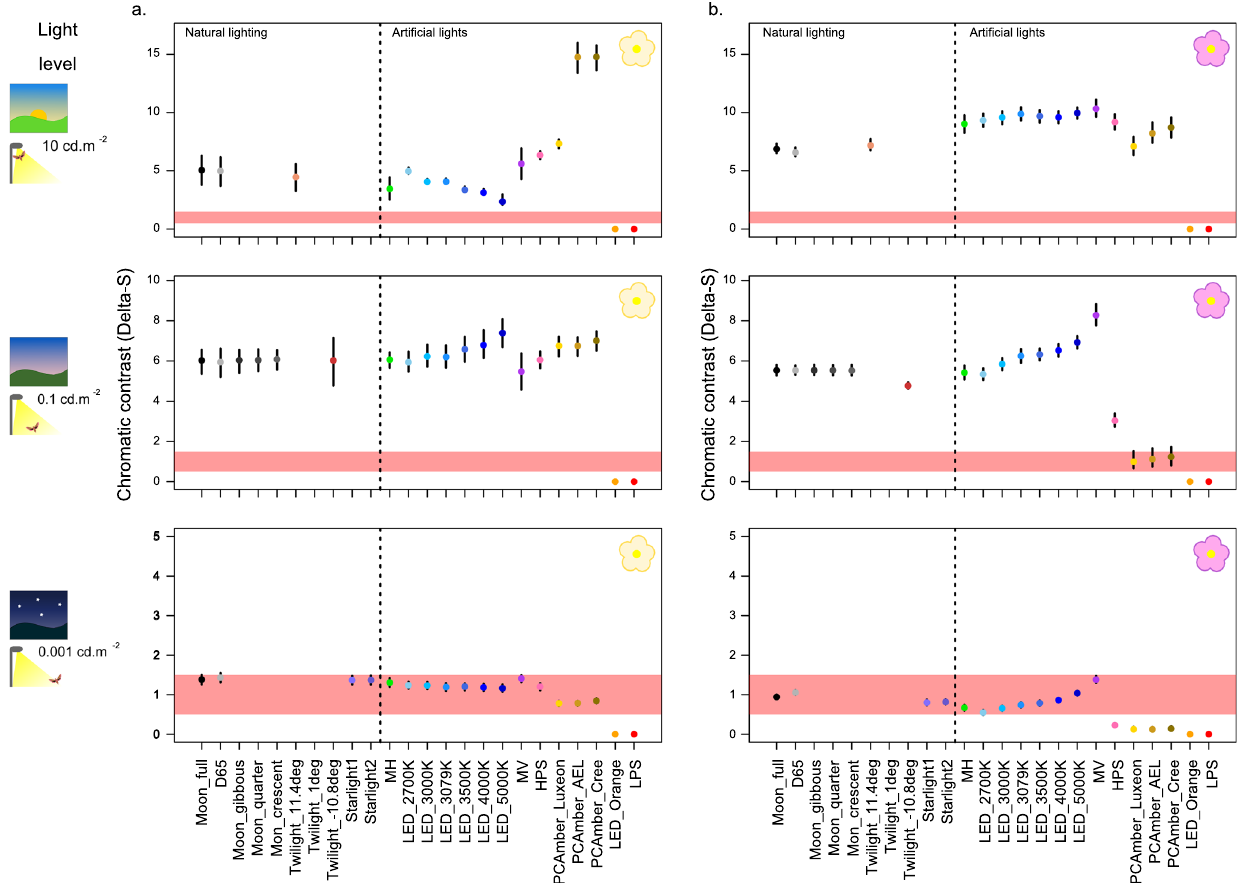
Fig. 2 Flower colour discrimination by moths under arti fi cial light. Bootstrapped estimates of chromatic distance (in Delta-S) between geometric means of fl oral colours ( N white/yellow = 60, N pink/purple = 80) and background colours ( N backgrounds = 953) in the hawkmoth RNL chromaticity space. Mean and 95% con fi dence intervals are shown for white/yellow fl owers ( a ) and pink/purple fl owers ( b ), under three light levels (10, 0.1 & 0.001 cd m − 2 , from top to bottom, represented by cliparts on the left-hand side), based on 1000 bootstrapped replicates per comparison. Each light type is represented by a different colour. The coloured bands represent putative thresholds for colour discrimination (Delta-S between 0.5 & 1.5). Full moon and D65 conditions are considered for every light level to provide consistent references, and additional relevant natural light types are included for each light level as appropriate. Source data are provided as a Source Data fi